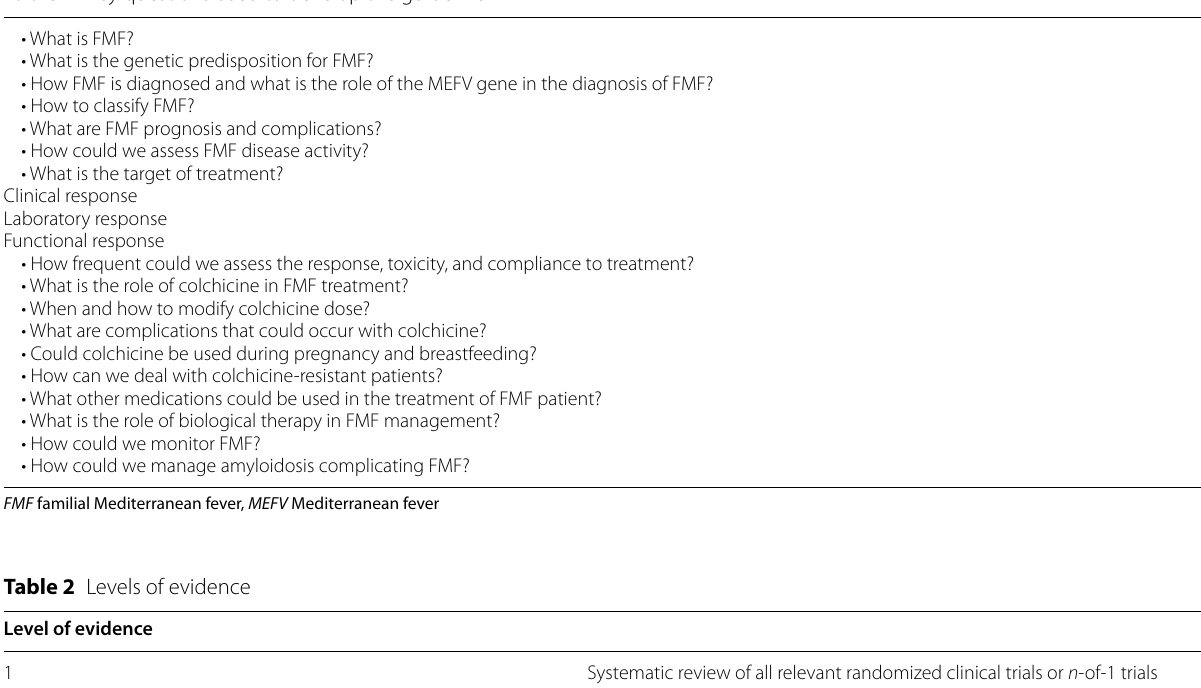
Table 1 Key questions used to develop the